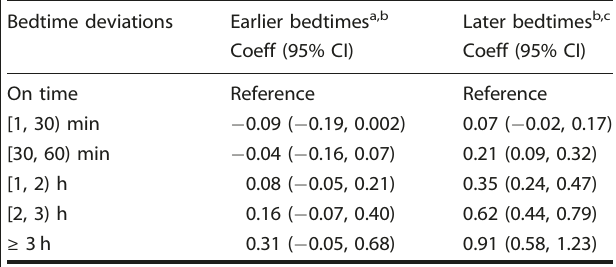
Table 3. Within-person differences in average resting heart rate during sleep across bedtime deviations.